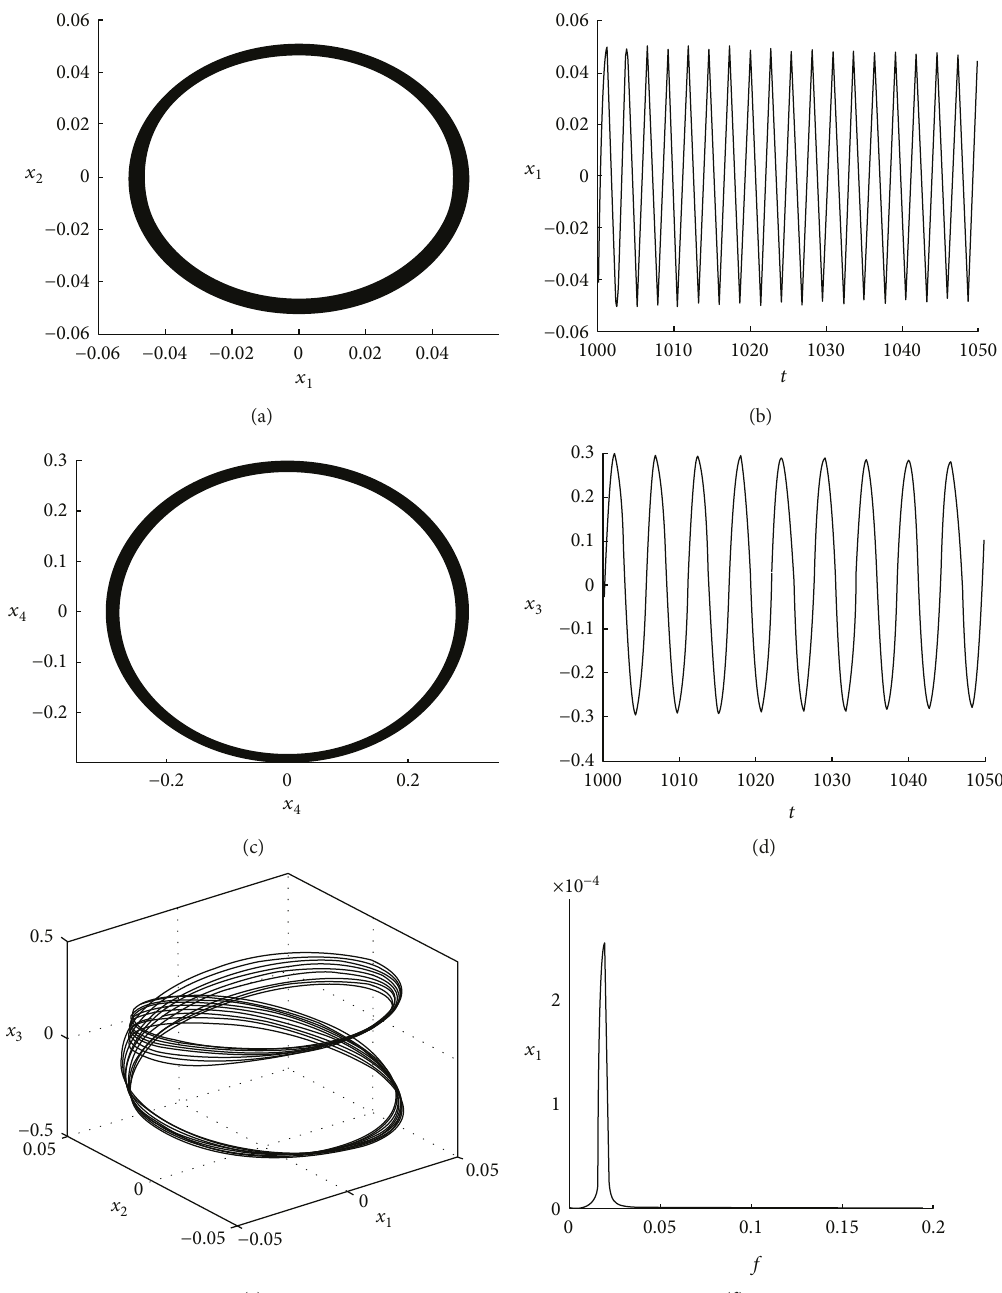
Figure 4: The multiperiodic motion of the blade with varying rotating speeds when Ω (b) the waveform on the plane t , x in the three-dimensional space x